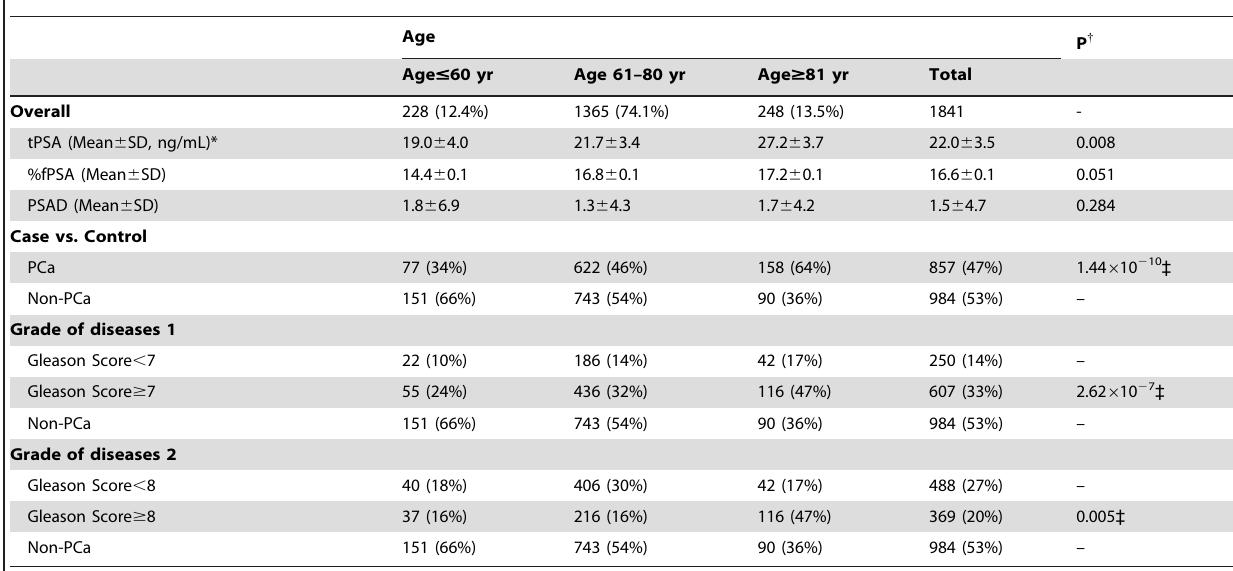
Table 1. Characteristics of the study population.